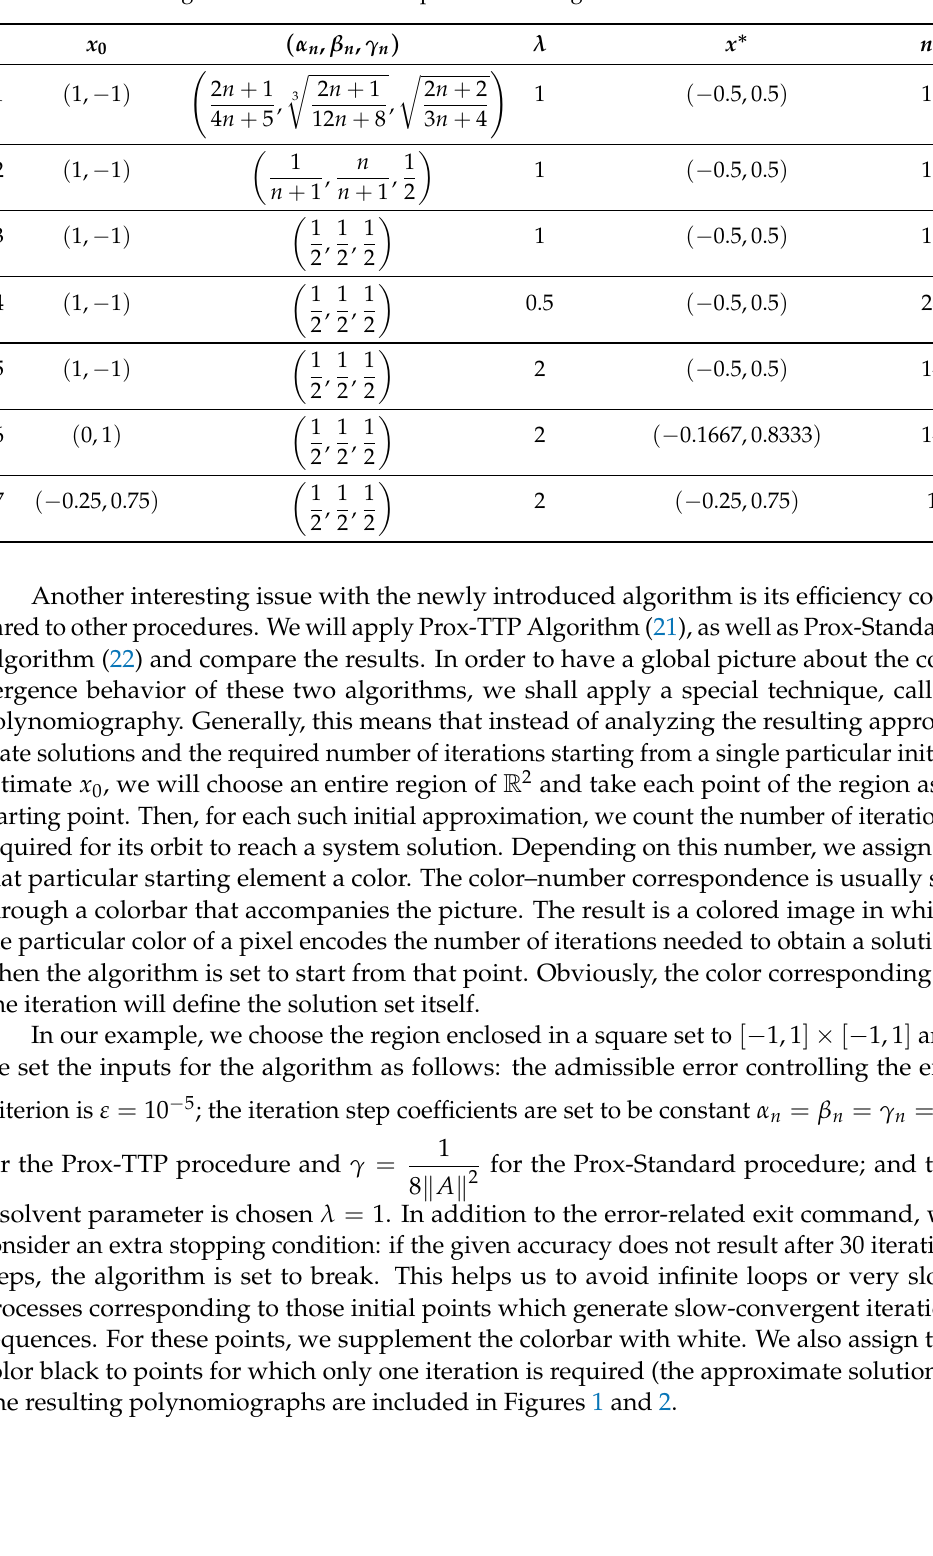
Table 1. The resulting solutions for different parametric